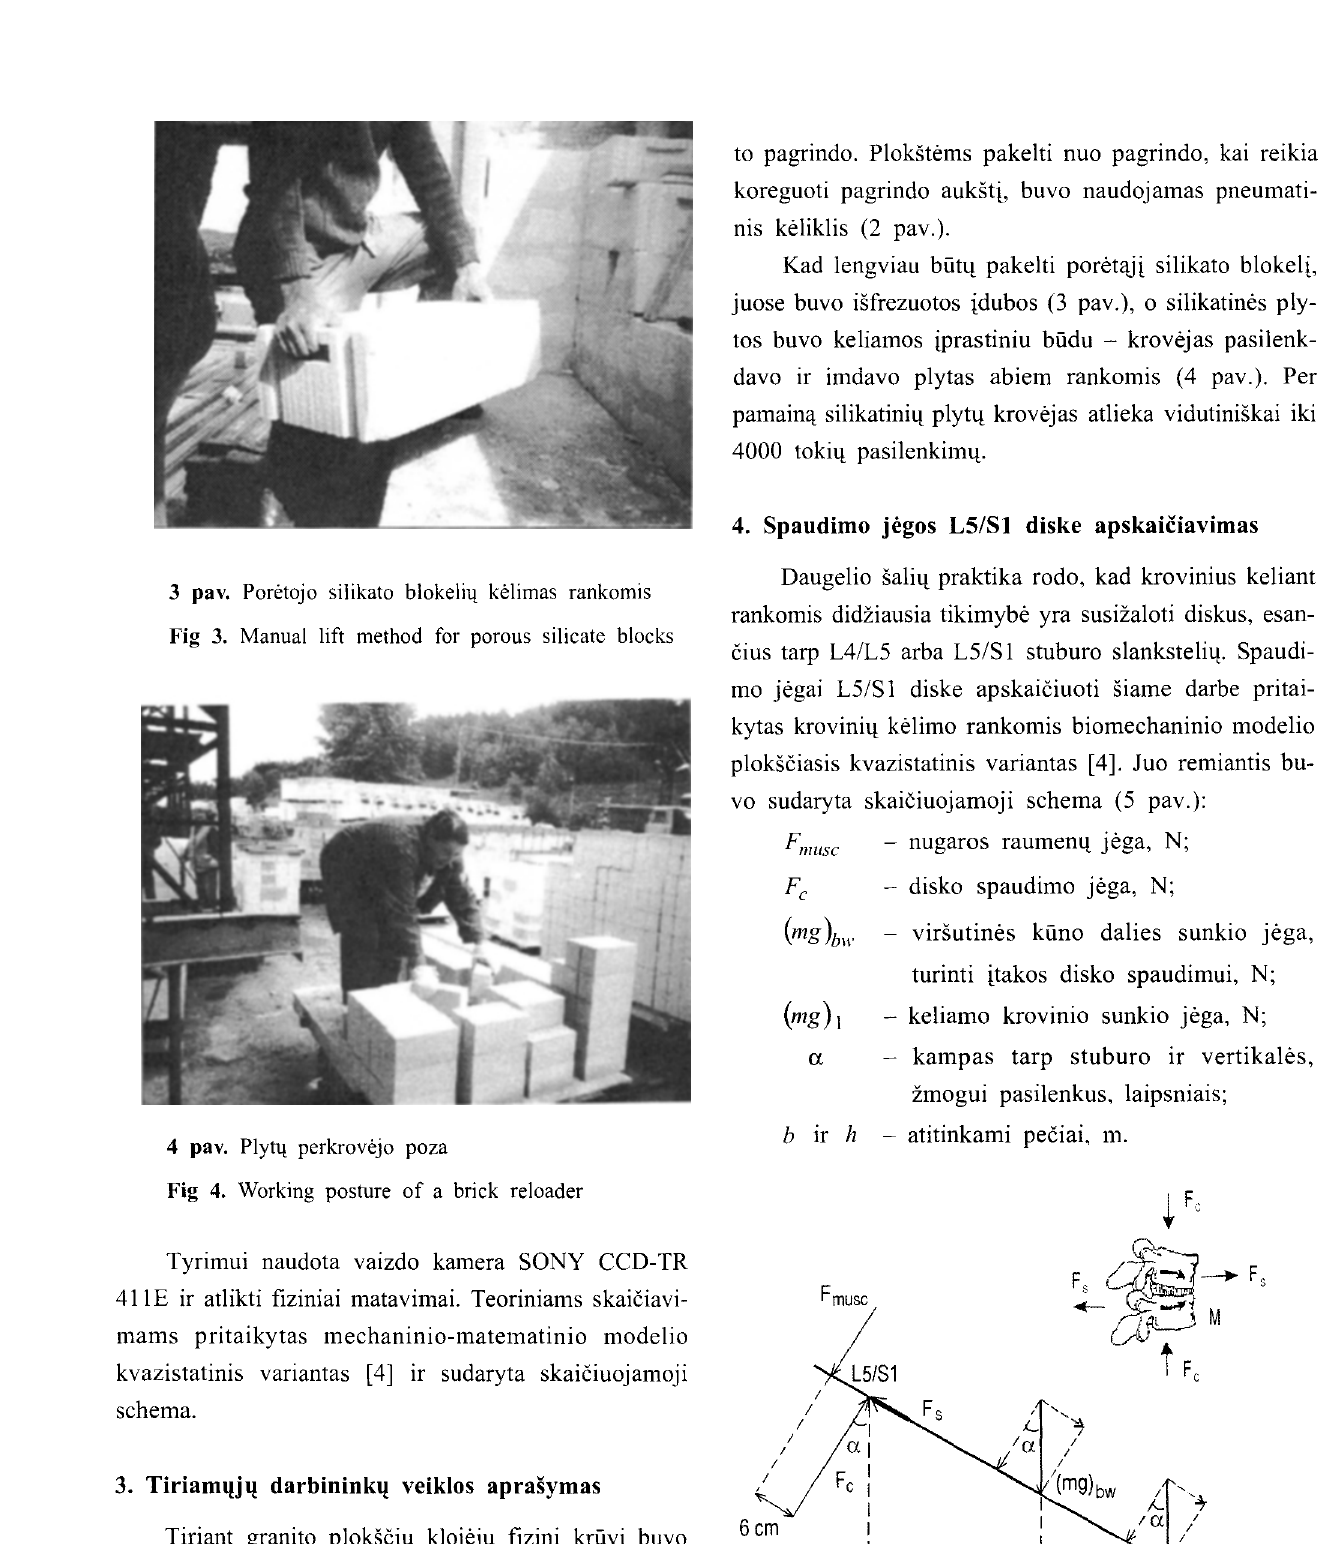
Fig 5. Scheme for calculating the L5/S I disc